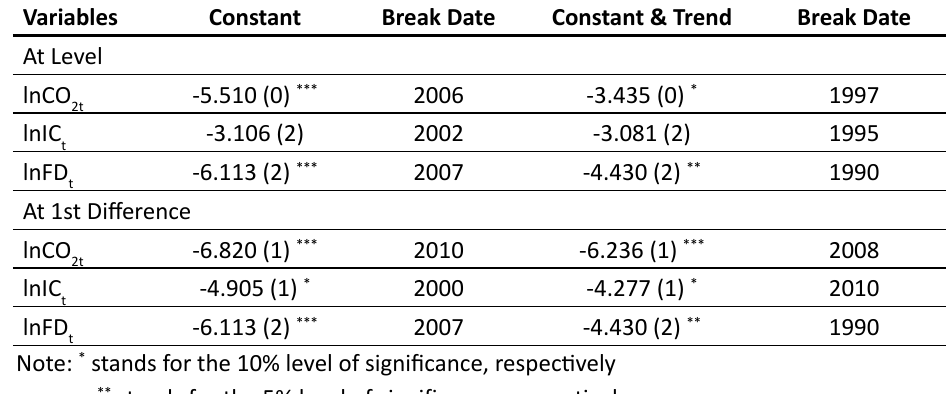
Table 4.Zivot-Andrew Structural Breaks Unit Root Test Result